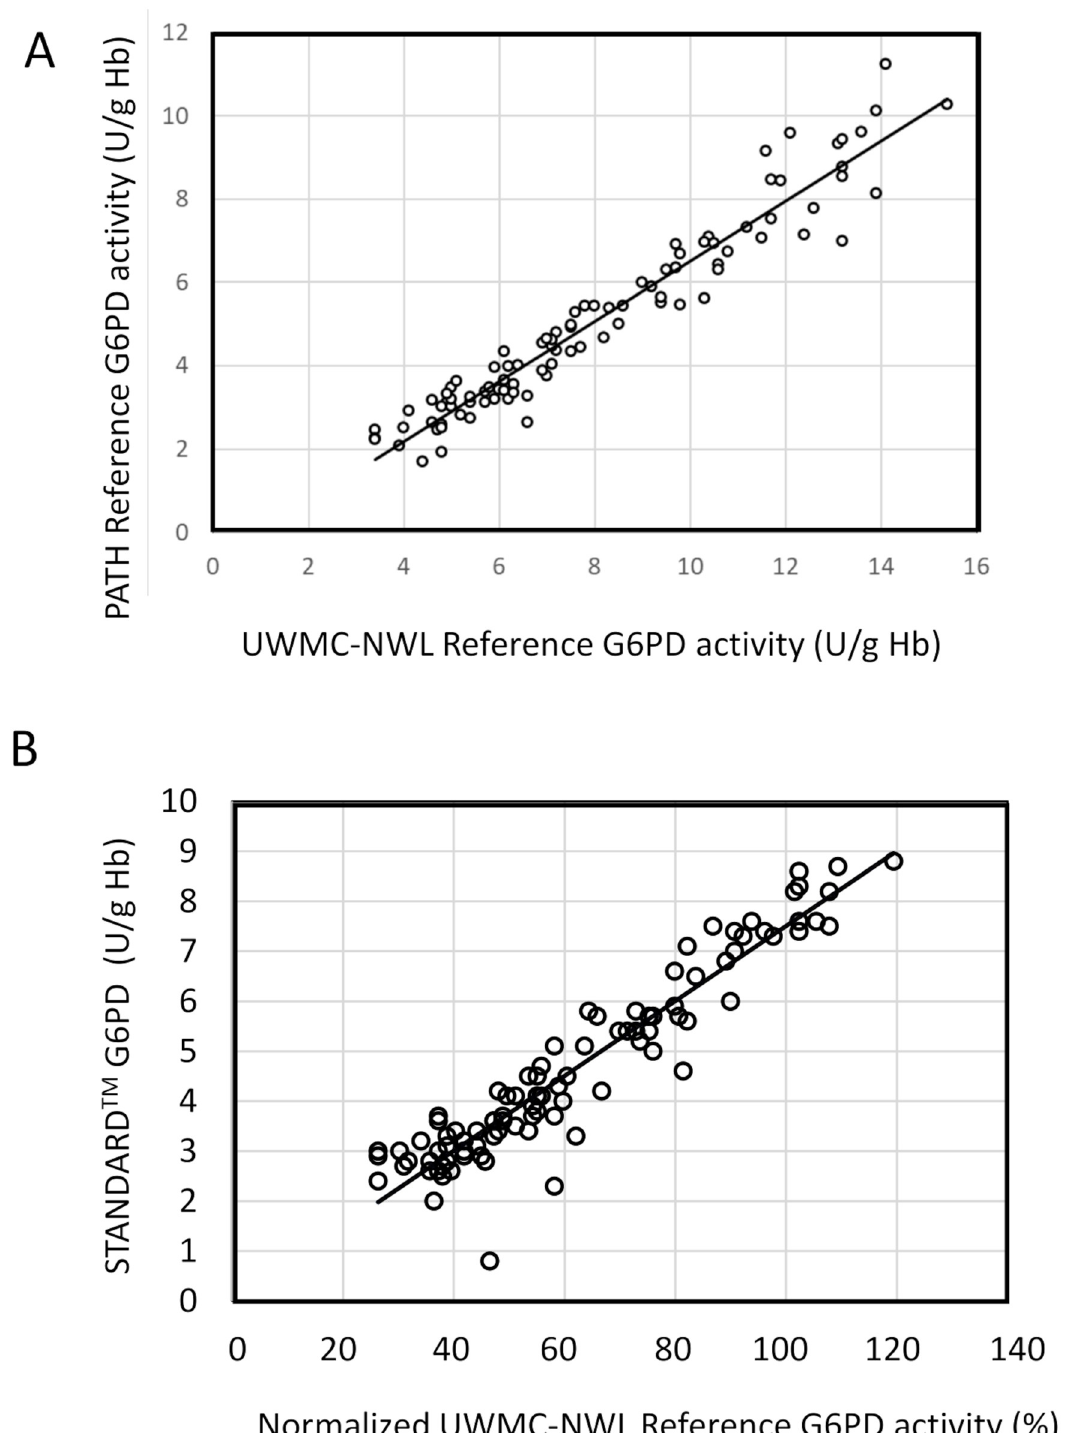
Fig 2. Linear correlations for STANDARD G6PD Test and reference G6PD values on contrived specimens spanning the medical decision limits. (A) Correlation between the Pointe Scientific reagent kit run on a spectrophotometer at one laboratory (PATH, Washington, USA) and on an automated clinical chemistry analyzer at a second laboratory (University of Washington Medical Center—Northwest clinical laboratory [UWMC-NW], Washington, USA). (B) Correlation between the STANDARD G6PD Test and normalized (to percent G6PD activity) UWMC-NW laboratory reference G6PD values. Solid lines represent the linear regression fits. https://doi.org/10.1371/journal.pone.0257560.g002 PLOS ONE | https://doi.org/10.1371/journal.pone.0257560 September 20,